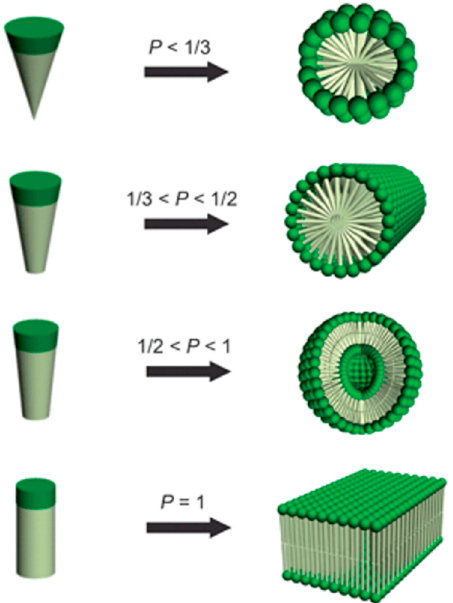
Figure 9. Dependence of nanostructure morphologies on the relative volume fraction of hydrophobic and hydrophilic blocks. (Reprinted with permission from Ref [95]. Copyright Royal Society of Chemistry).